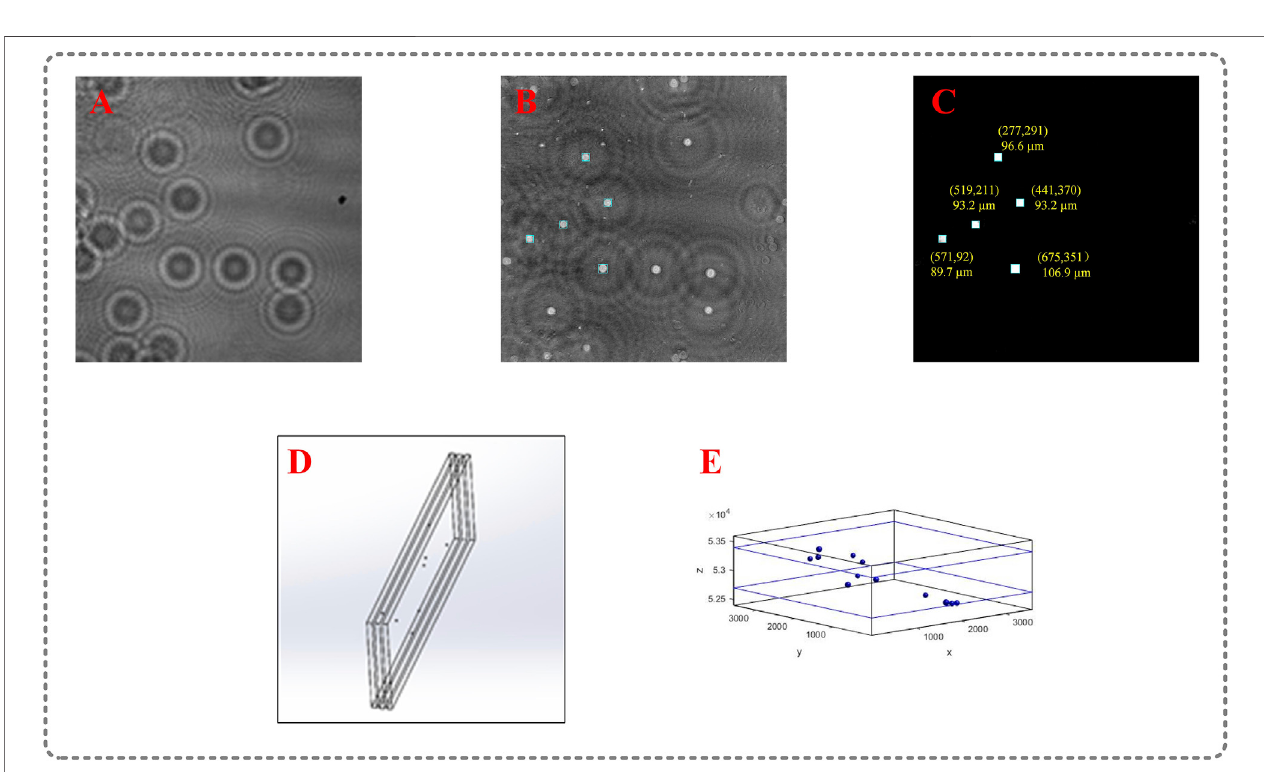
FIGURE4| Experimental result; (A) captured hologramwithmultipleparticles; (B) theraw-reconstructed image at52.7mm; (C) prediction oftheU-netmodel; (D) particle fi eld of the second dataset; (E) 3D distribution of particle fi eld.